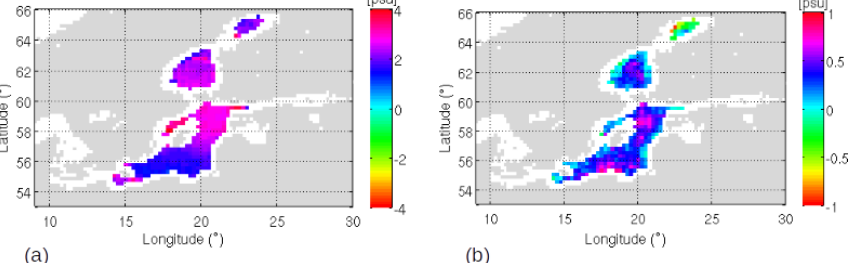
Figure 23. (a) Difference between SMAP JPL and Baltic+ L3 SSS error standard deviations [psu], (b) difference between SMAP REMSS and Baltic+ L3 SSS error standard